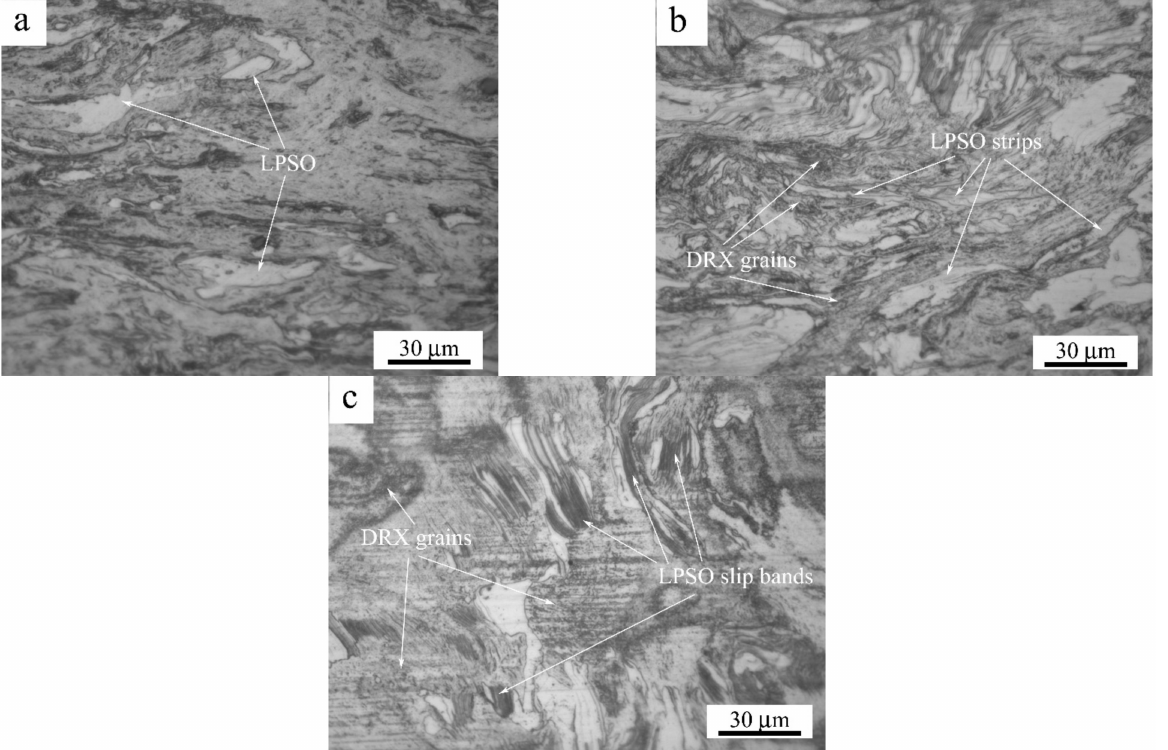
Figure 5. Optical microstructures in the near surface region for sliding at 150 ◦ C under different loads: ( a ) 40 N, ( b ) 80 N, ( c ) 120